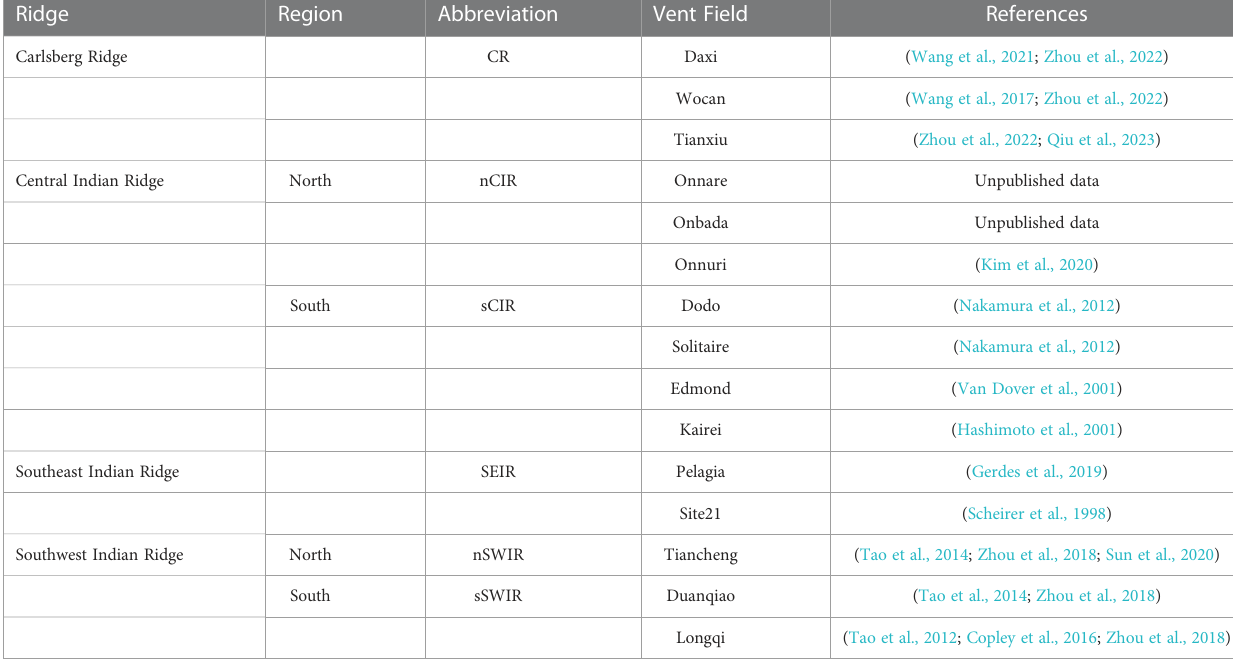
TABLE 1 Active hydrothermal vent fi elds with ecosystem in the Indian Ocean. Ridge